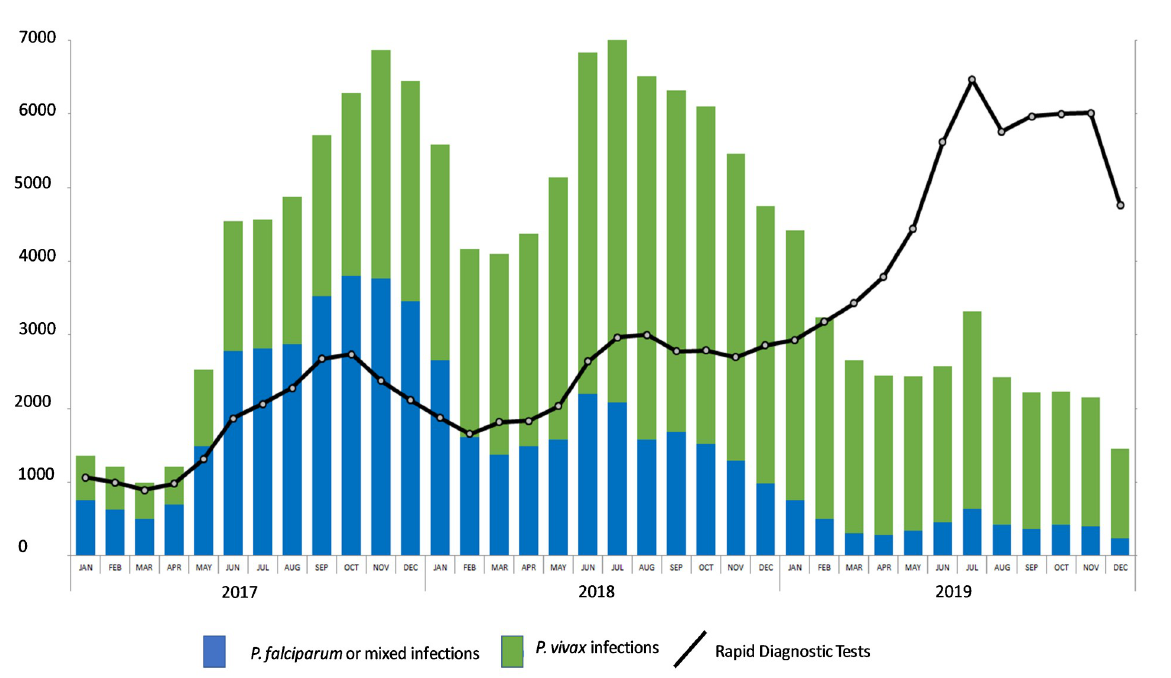
Fig 2. Monthly malaria cases reported by Cambodian National Malaria Control Programme CNMCP information system between 2017–2019 [3]. The number of rapid diagnostic tests (RDTs) increased while the number of diagnosed cases dropped.